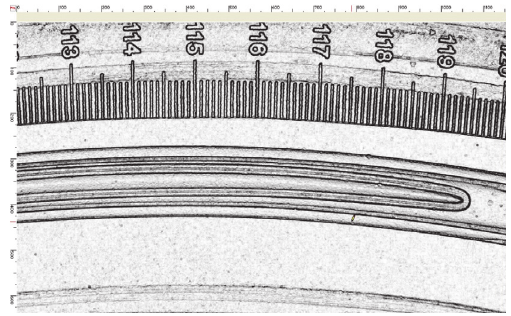
Figure 16: Boundary detection.